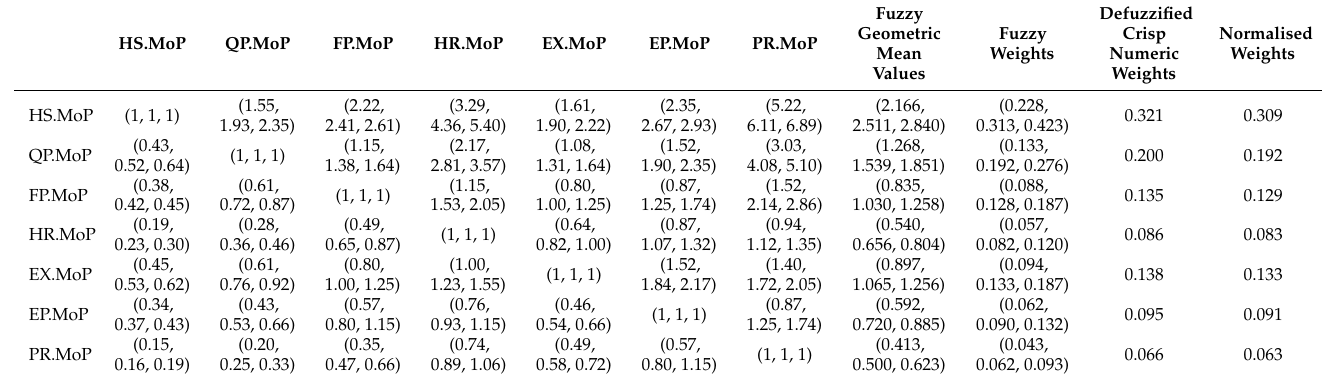
Table 7. Aggregated pairwise comparison matrix with subsequent